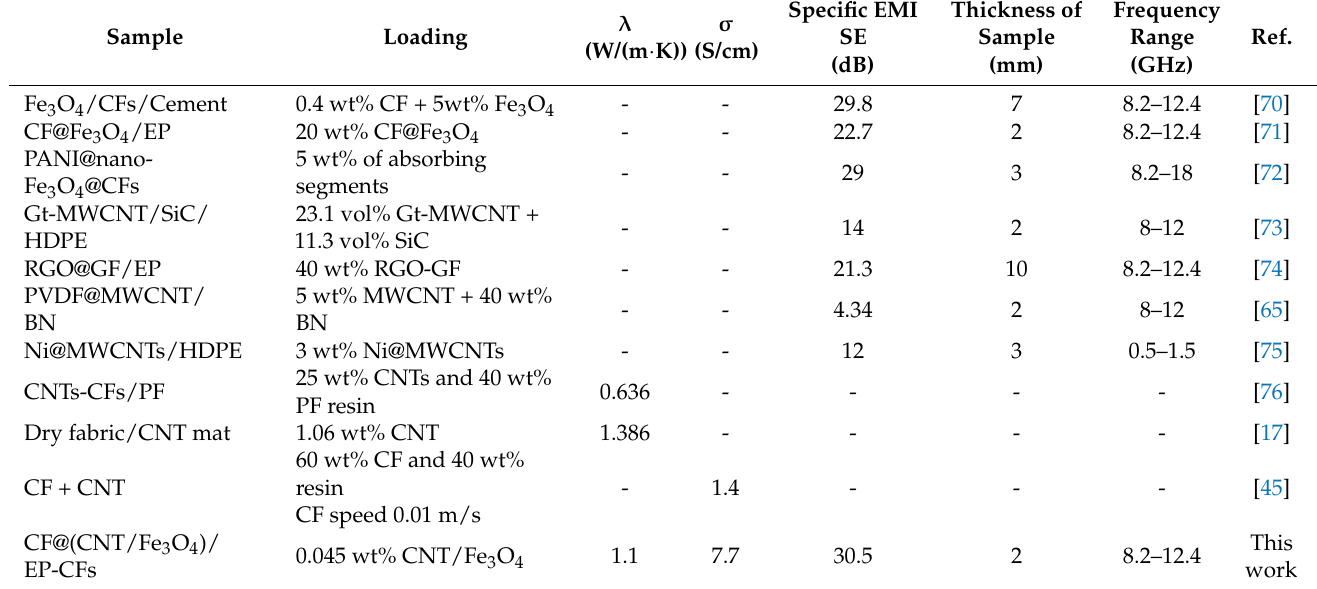
Table 2. Comparison of the λ , σ and EMI SE for some related